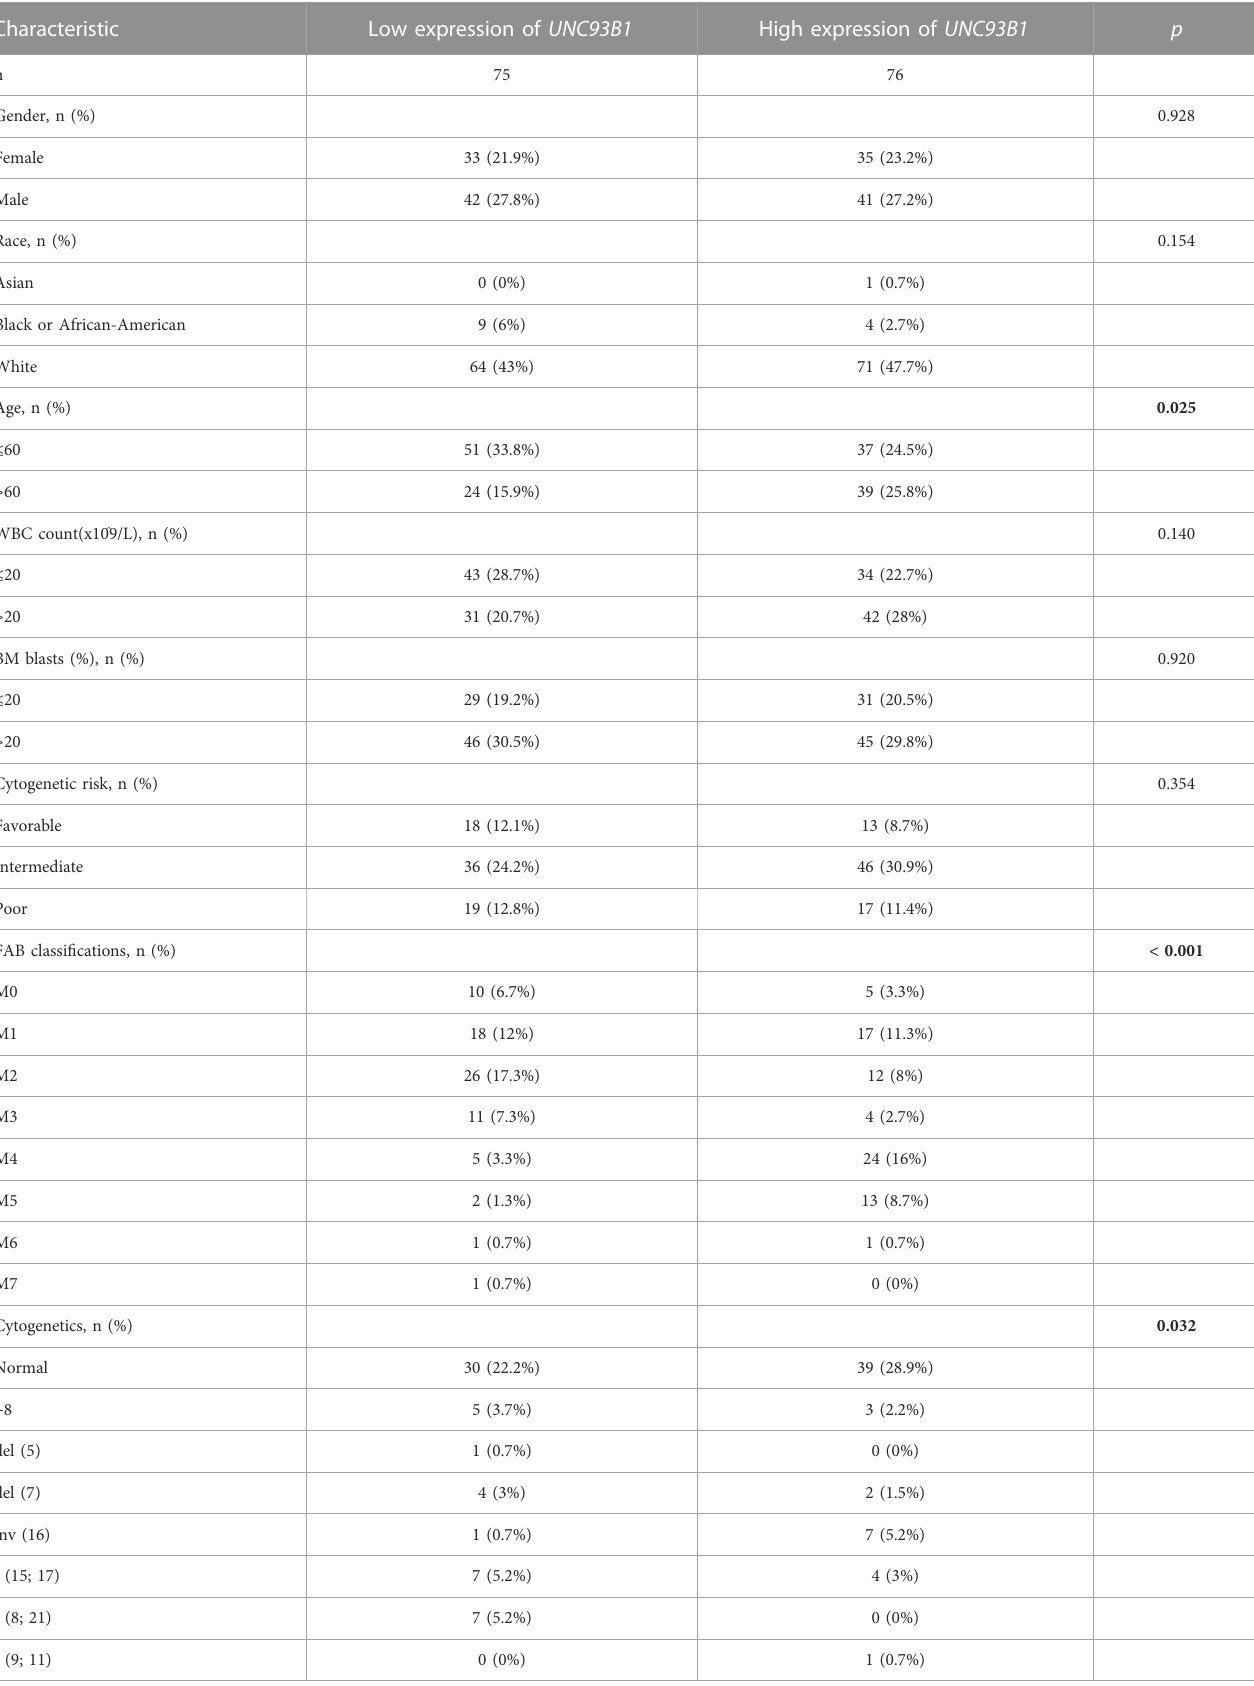
TABLE 1 Clinical characteristics of AML patients in two groups divided by the level of UNC93B1